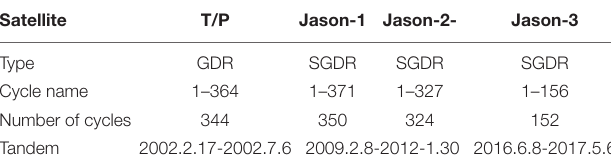
TABLE 1 | Statistics of satellite altimeter data used in this